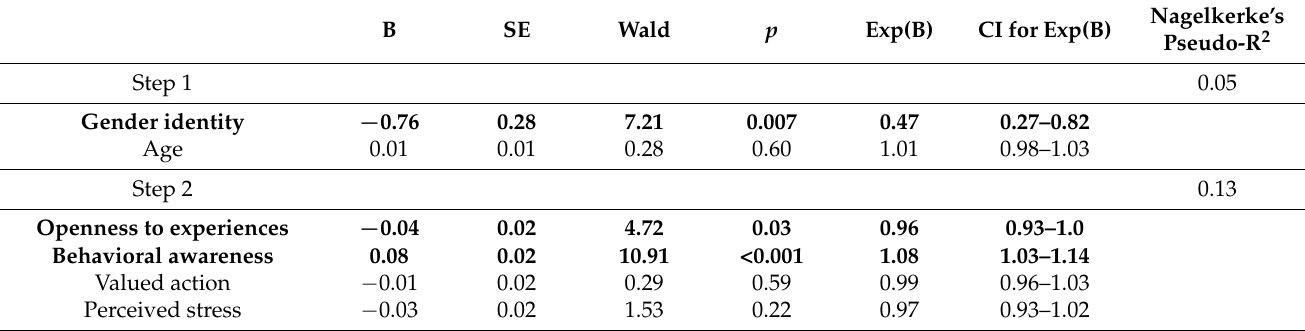
Table 2. Mask adherence, as predicted by psychological flexibility components and perceived